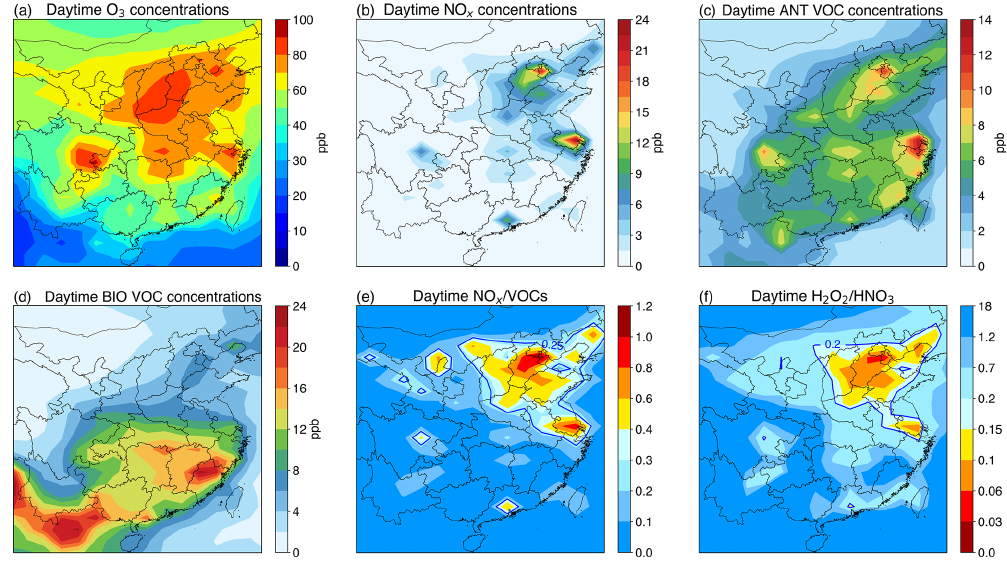
Figure 5. Spatial distributions of simulated surface daytime O 3 , NO x , anthropogenic VOCs, biogenic VOCs (ppb) (a–d) , and two O 3 sensitivity ratios – NO x / VOCs and H 2 O 2 / HNO 3 (e, f) – in JJA, 2016, China. Table 3. Simulated surface daytime concentrations of species, radicals, O 3 sensitivity ratios and the photolysis rate j( O 1 D ) for the six industrial regions in JJA, 2016, China. Region Beijing Shijiazhuang Shanghai Nanjing Guangzhou